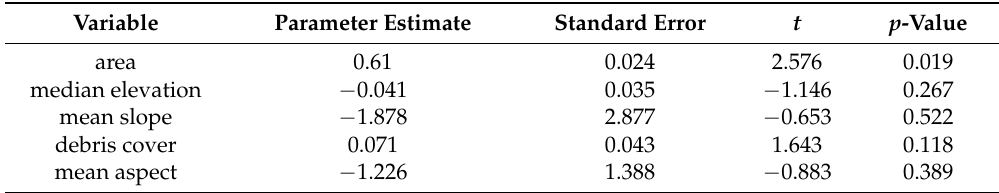
Table 3. Summary of the multiple linear regression analysis in the SPSS software package (T-value ( t ) and p -value are two parameters obtained from the t